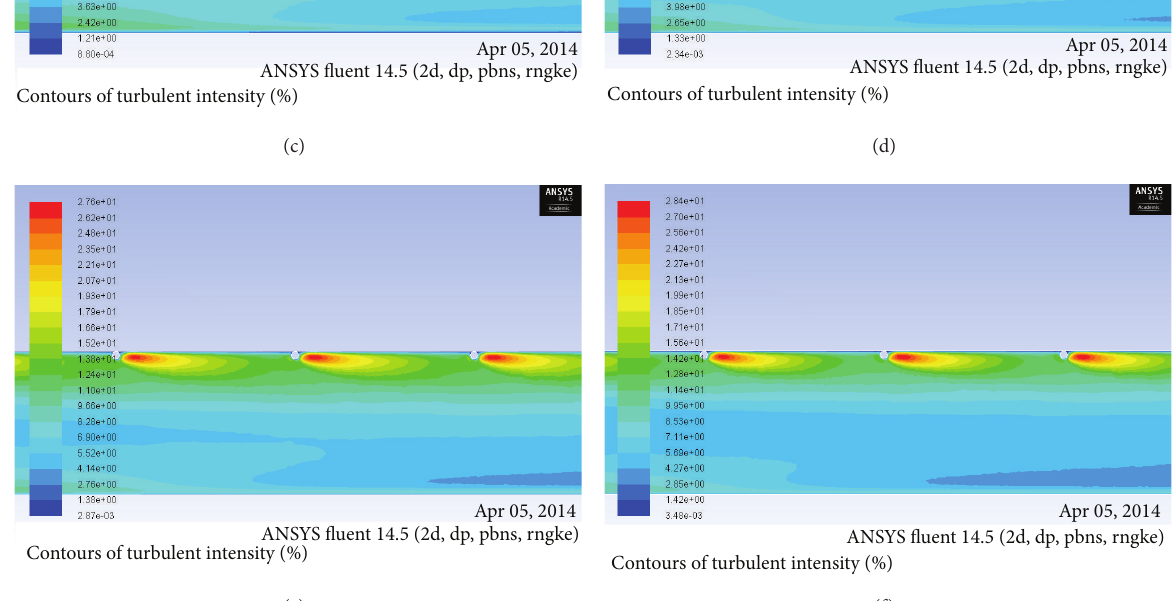
is also plotted in Figure 10. Here also the maximum friction factor is obtained at 𝑃/𝑒 =10 and Reynolds number of